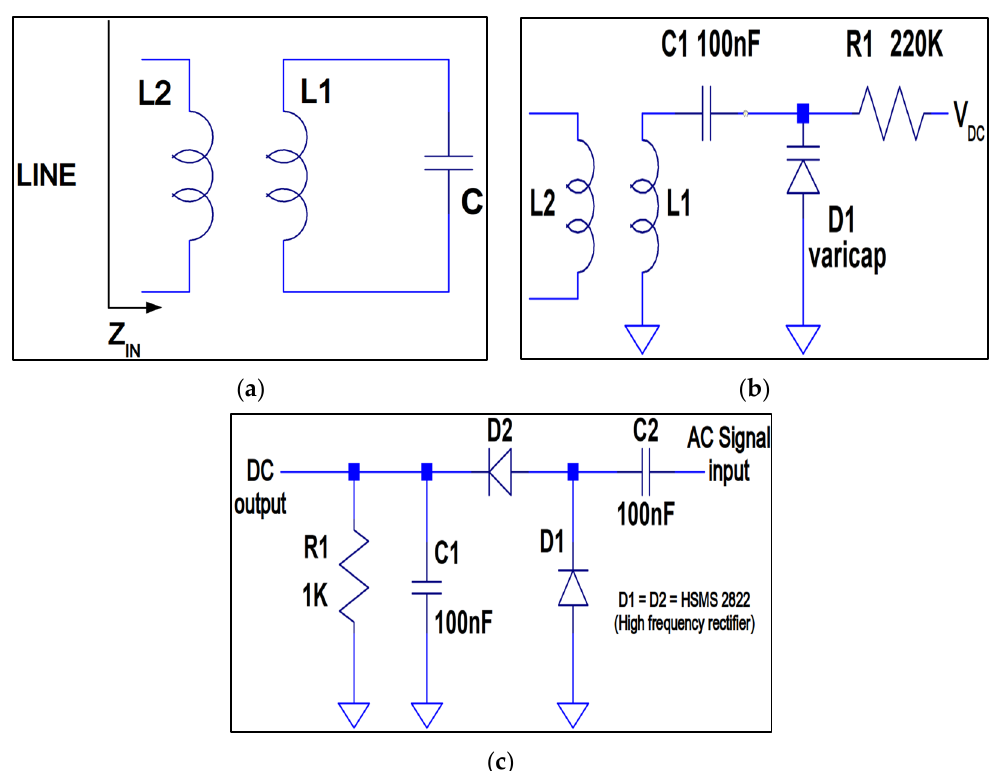
Figure 4. Schematic of tuning circuit in ( a ) its generic representation and ( b ) actual implementation, and ( c ) schematic of voltage doubler detection circuit .